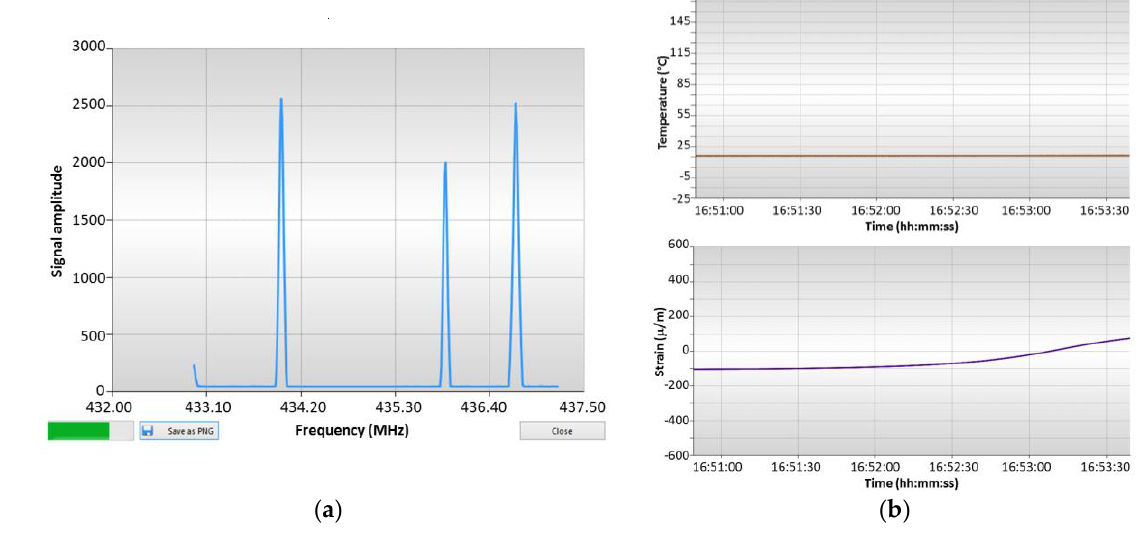
Figure 2. ( a ) “Oscilloscope” mode of interrogation unit, showing the response of sensor SSE E017 and the two resonance peaks of sensor TSE F162; ( b ) typical temperature and strain output windows.